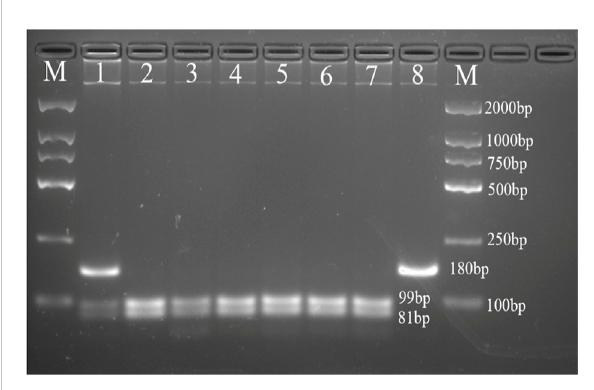
FIGURE 1 Agarose gel picture showing digested PCR products for FABP2 gene polymorphism. M, marker; 1 shows Ala/Thr genotype; 2, 3, 4, 5, 6, and 7 show Ala/Ala genotype; 8 shows Thr/Thr